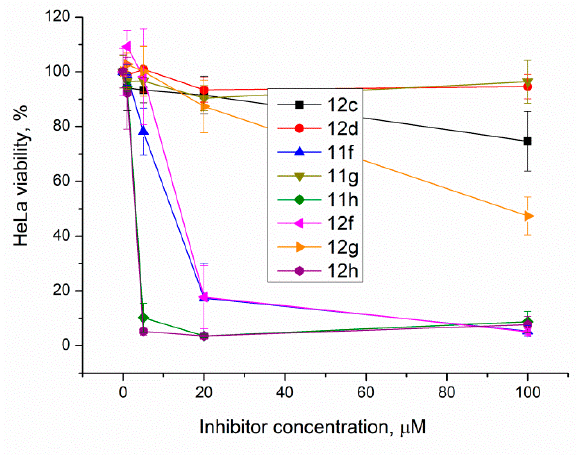
Figure 4. The berberine derivatives’ cytotoxicity according to the EZ4U test. Error bars show standard deviations.